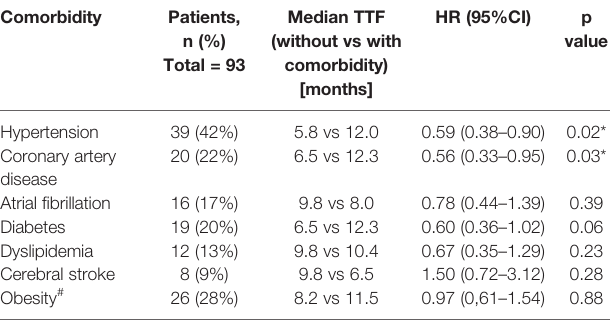
TABLE 2 | The prevalence of comorbidities and their impact on TTF.